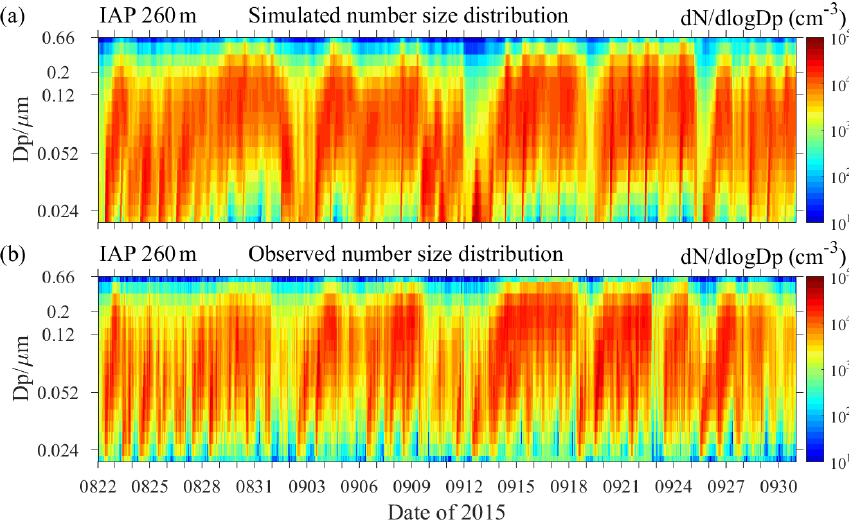
Figure 2. (a) Simulated and (b) observed particle number size distribution at high level (260m) in Beijing from 22 August to 30 September